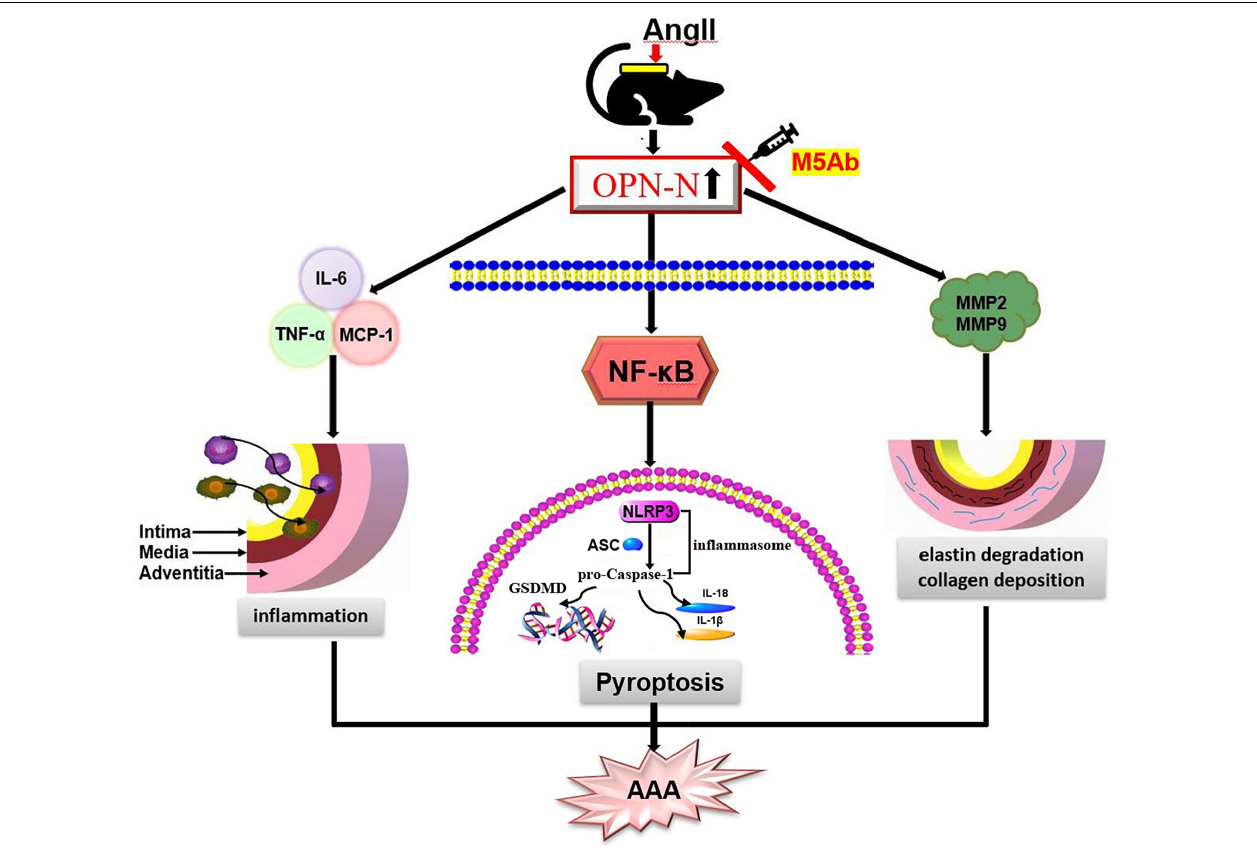
FIGURE 9 | Schematic diagram of the function of OPN-N in the AngII-induced AAA. OPN-N as a pivotal pro-inflammatory cytokine induces pyroptosis and inflammation through the activation of its NF- κ B pathway aggravates AAA formation. OPN-N influences aneurysm formation in multiple ways, such as increasing the expression of TNF- α , IL-6, and MCP-1 and enhancing the production of MMP2 and MMP9, which further activates the elastin degrade and increases compensatory collagen deposition. Abbreviations: AAA, abdominal aortic aneurysm; OPN-N, osteopontin N-terminal